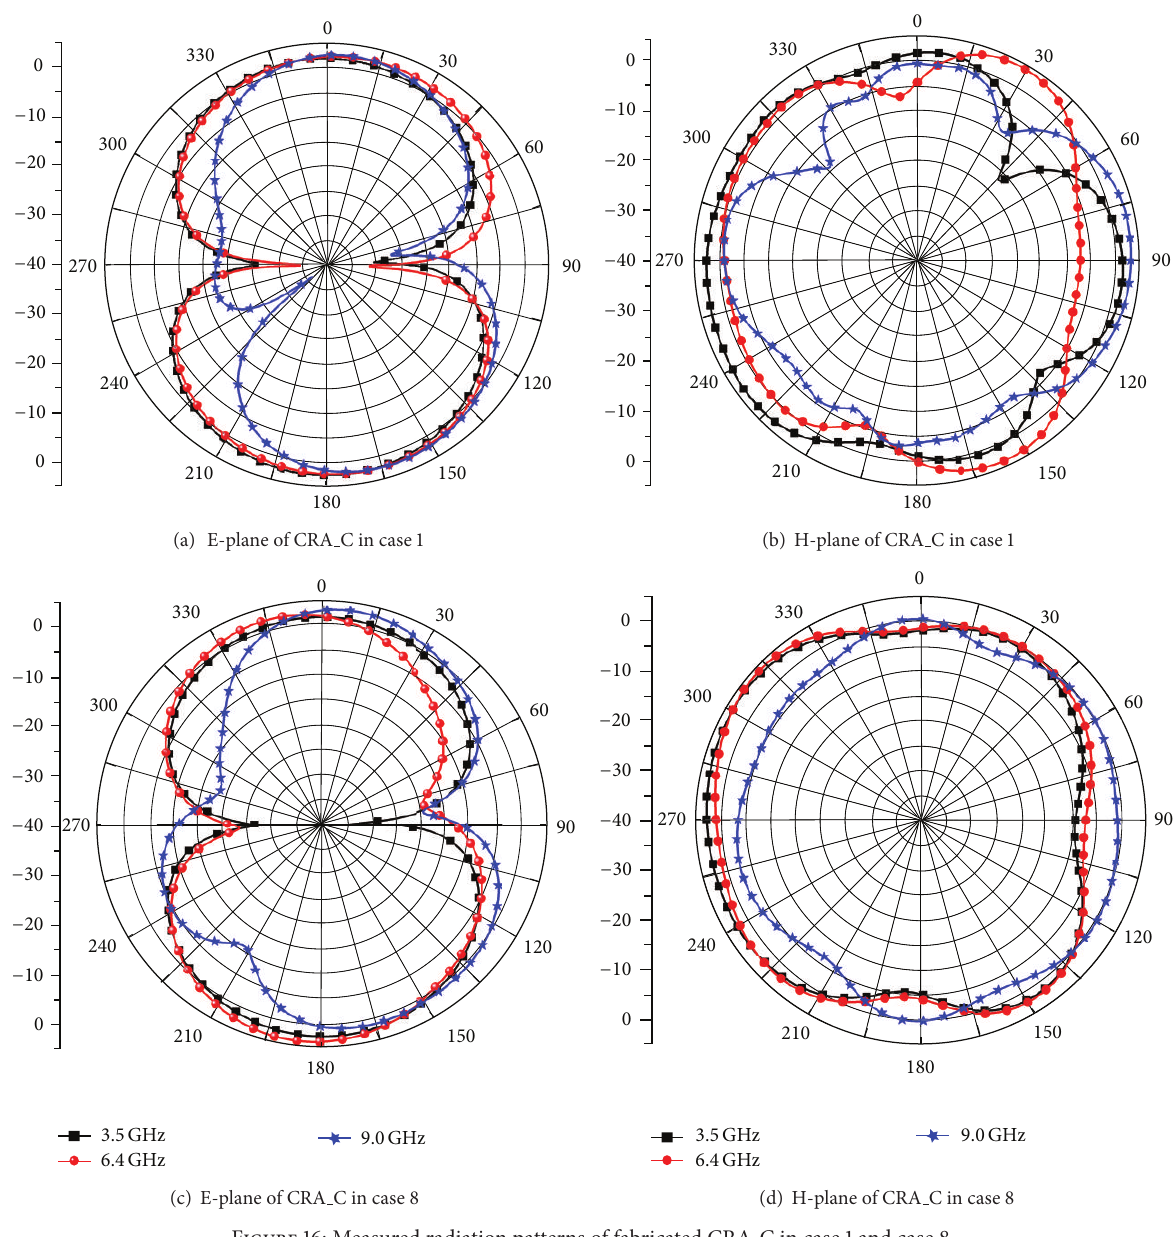
Figure 16: Measured radiation patterns of fabricated CRA C in case 1 and case